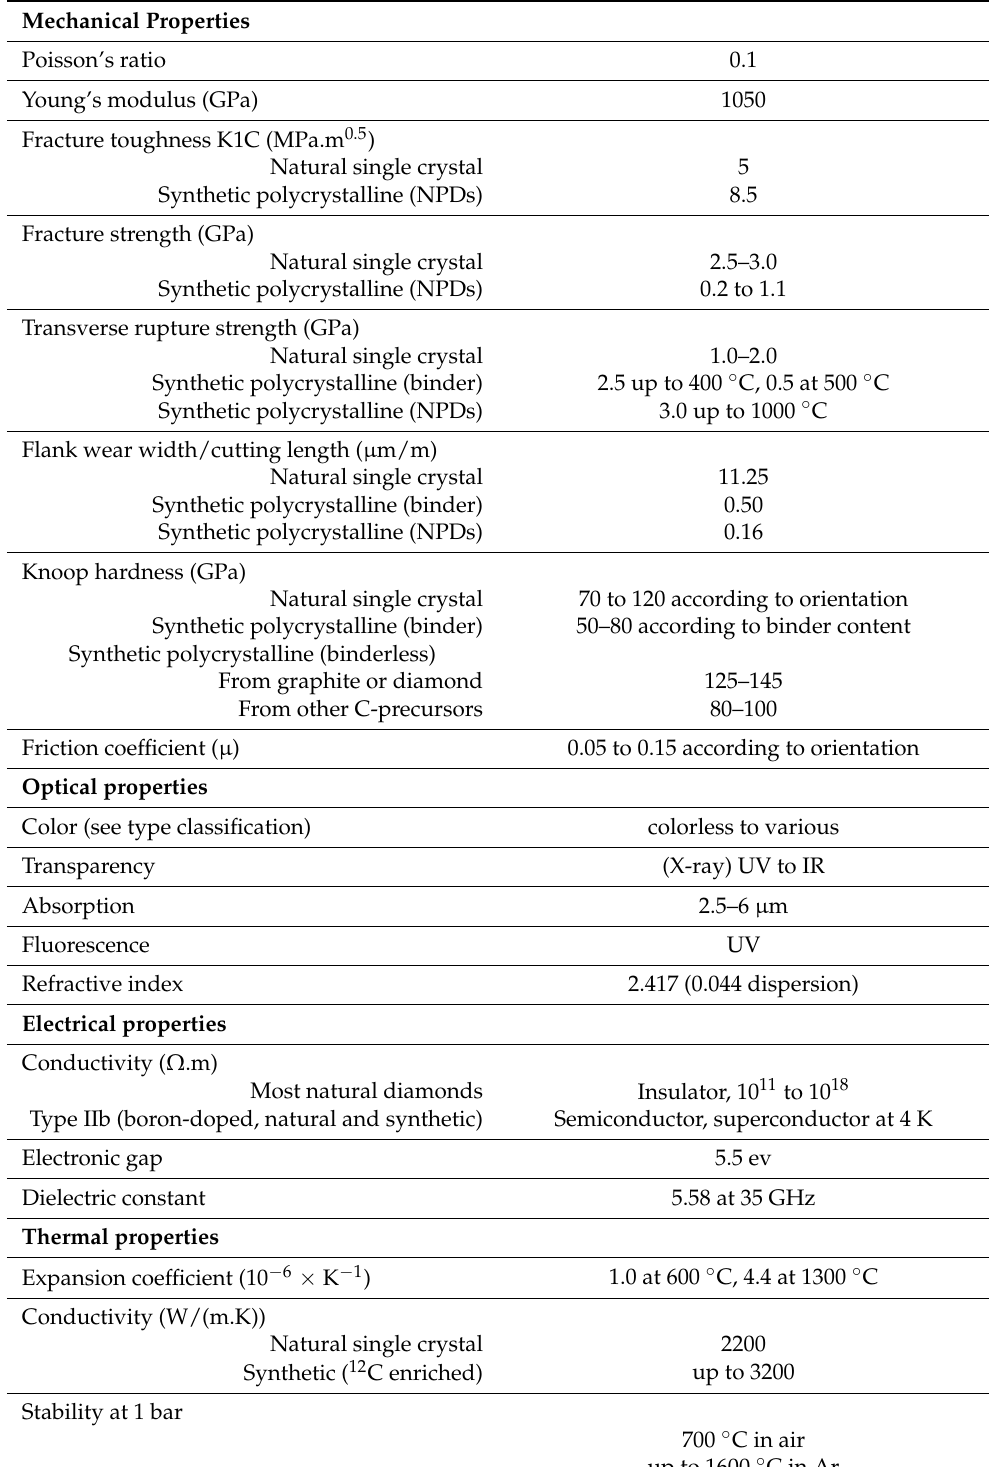
Table 3. Common physical properties of